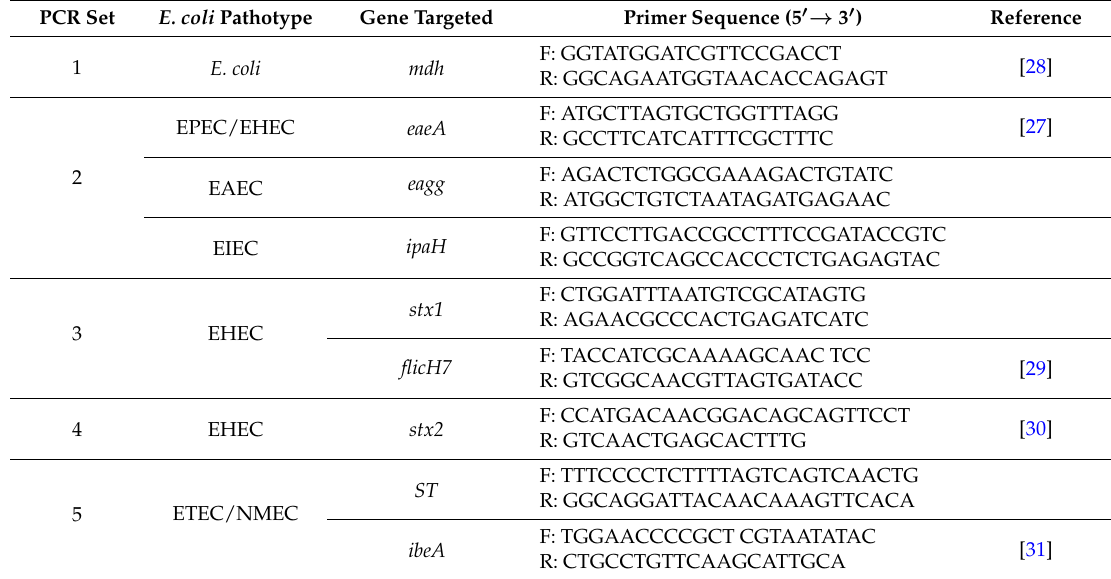
Table 1. Primer sequences used for the identification of E. coli virulence-associated genes. PCR